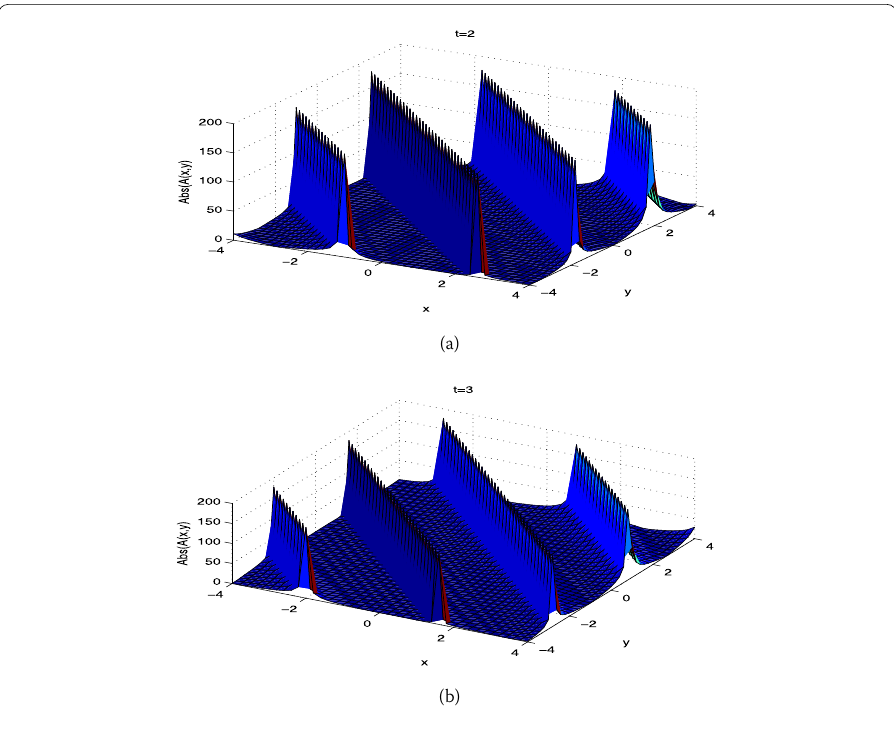
Figure 1 ( a ) The exact solution represented by Eq. (78), t = 2, α = 1, β = 1, γ = 1. ( b ) The exact solution represented by Eq. (78), t = 3, α = 1, β = 1, γ = 1